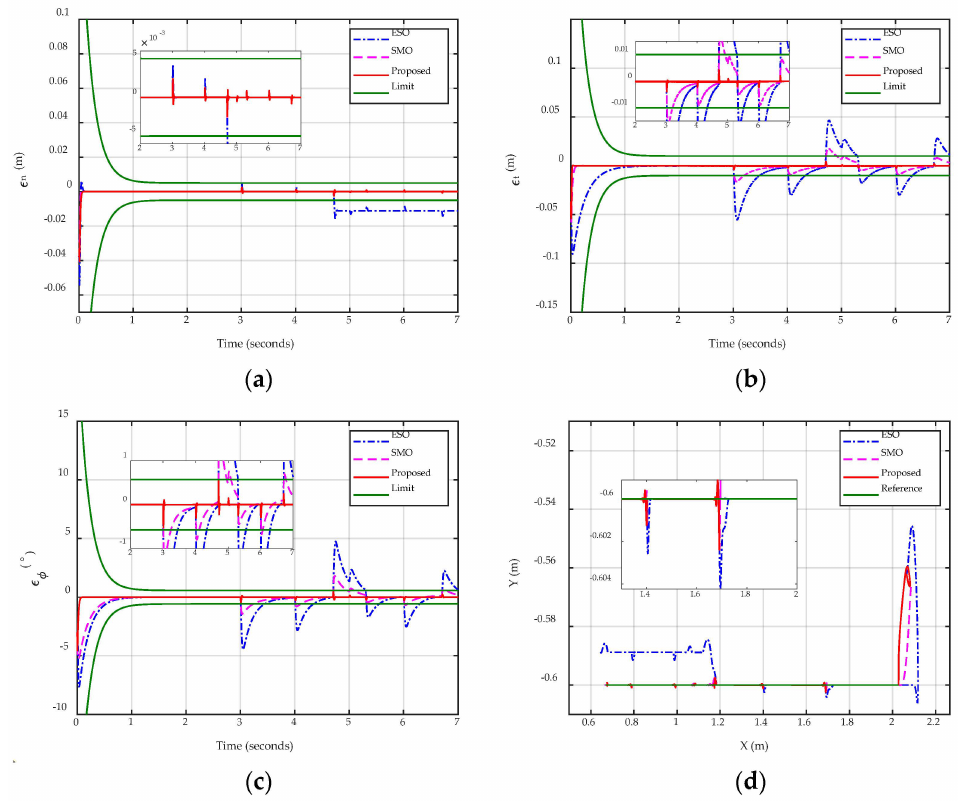
Figure 5. Control performance in terms of ( a ) contouring error, ( b ) tangential error, ( c ) orientation error, and ( d ) contour shape in Case